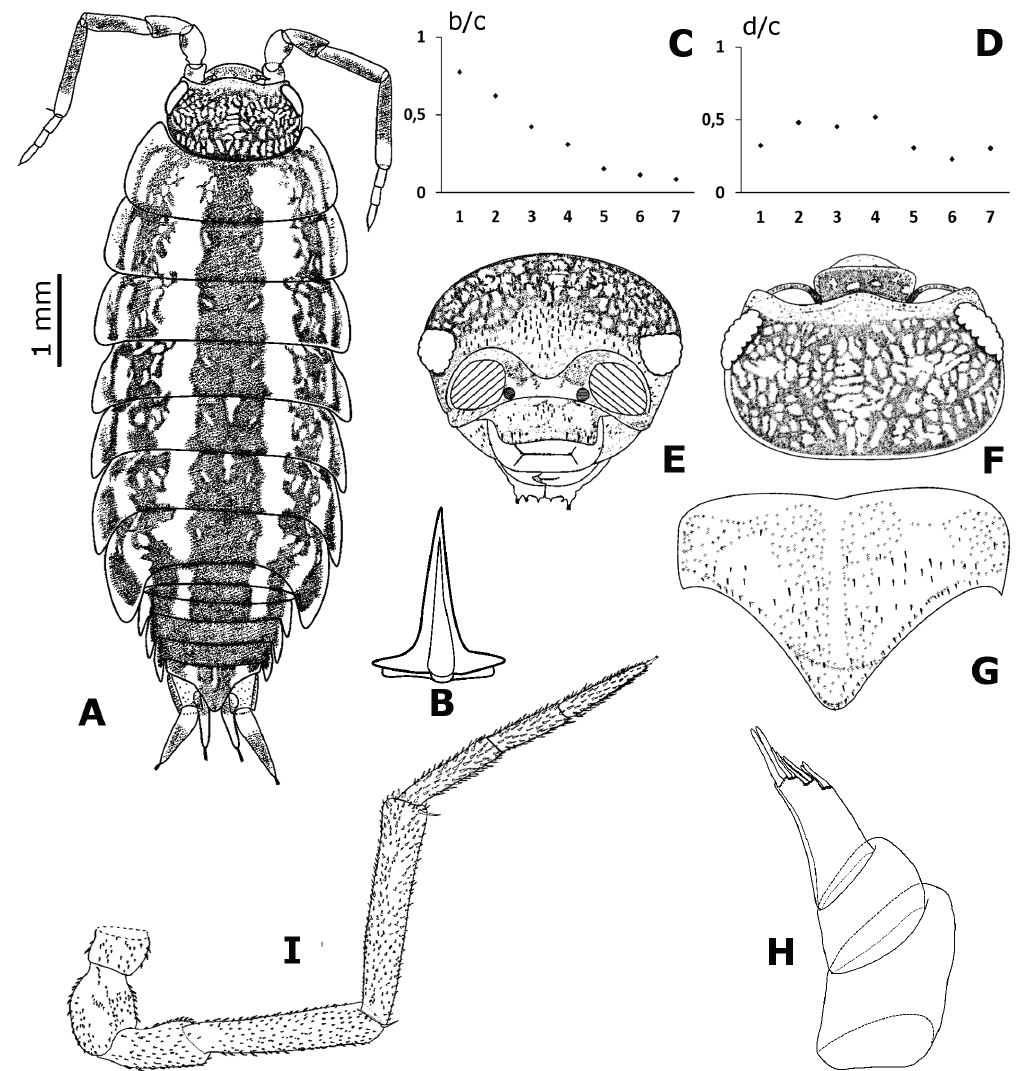
Figure 2. Pulmoniscus turbanaensis n. sp. ♀ Paratype (CUDC-CRU 14): A. Dorsal habitus; B. Dorsal scale-seta, C. b/c noduli laterales coordinates; D. d/c noduli laterales coordinates; E. Cephalon, frontal view; F. Cephalon, dorsal view; G. Telson; H. Antenna; I.